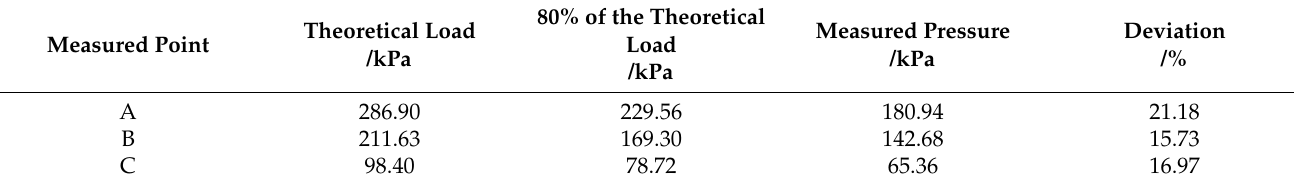
Table 4. Comparison of the calculation and